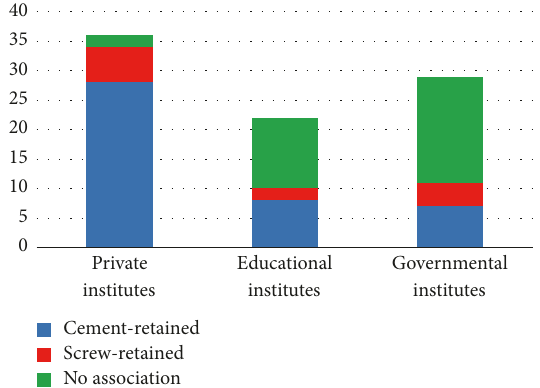
Figure 4: Type of retention system.